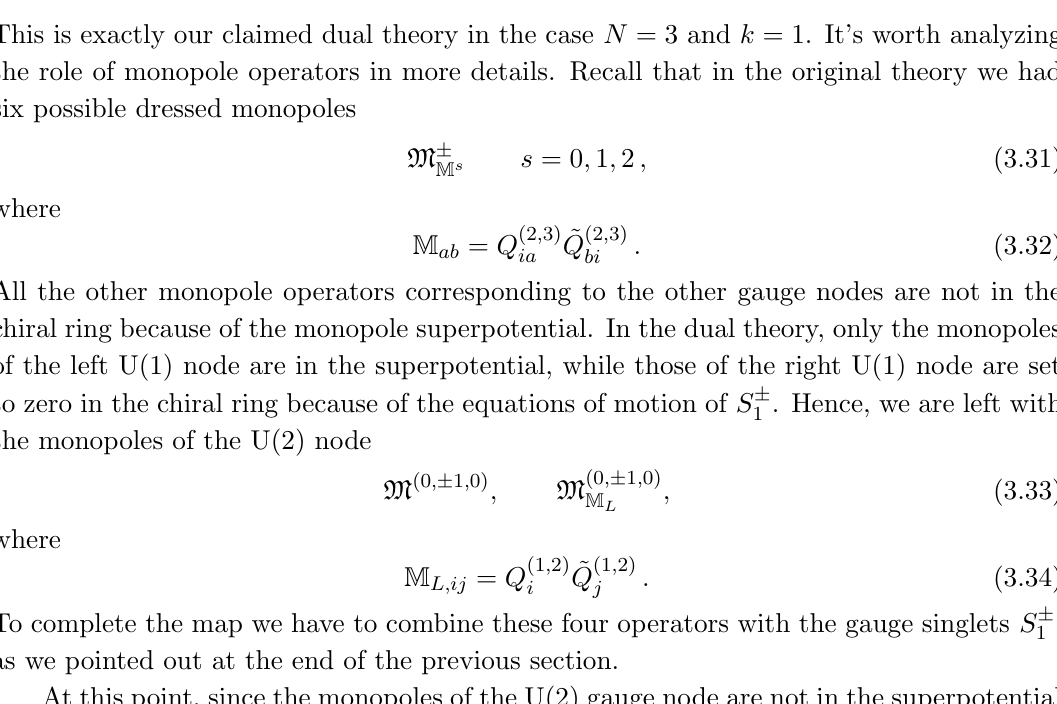
Figure 12 . Quiver diagram after the application of Aharony duality on the right node. This coin- cides with the one of (cid:12)gure 9 predicted by the recombination duality in the case N = 3 and k =